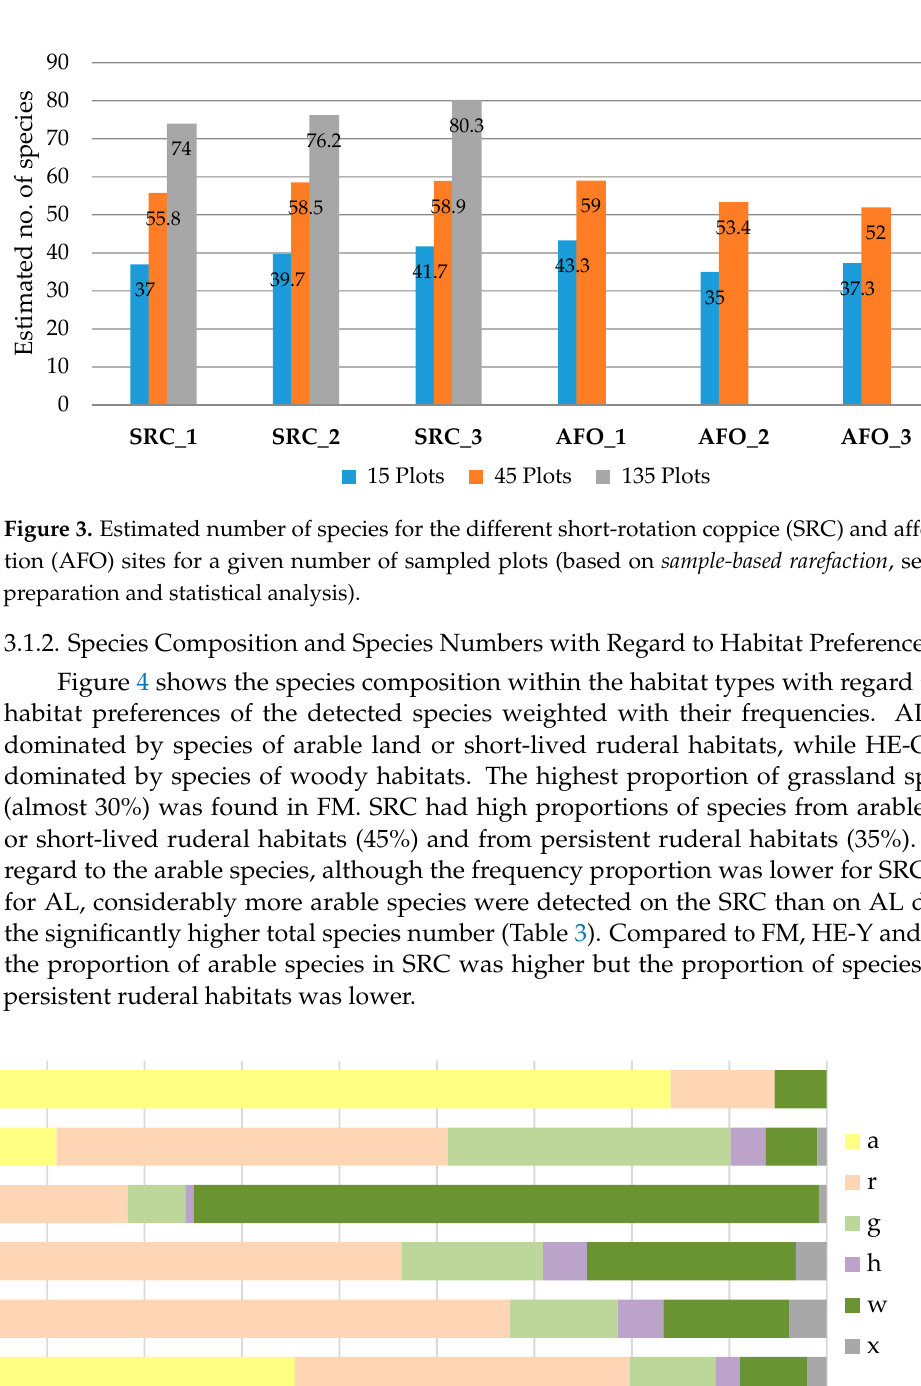
breviations) weighted with their frequencies. Data of all sites, stands and plots included per type. Abbreviations for hab-